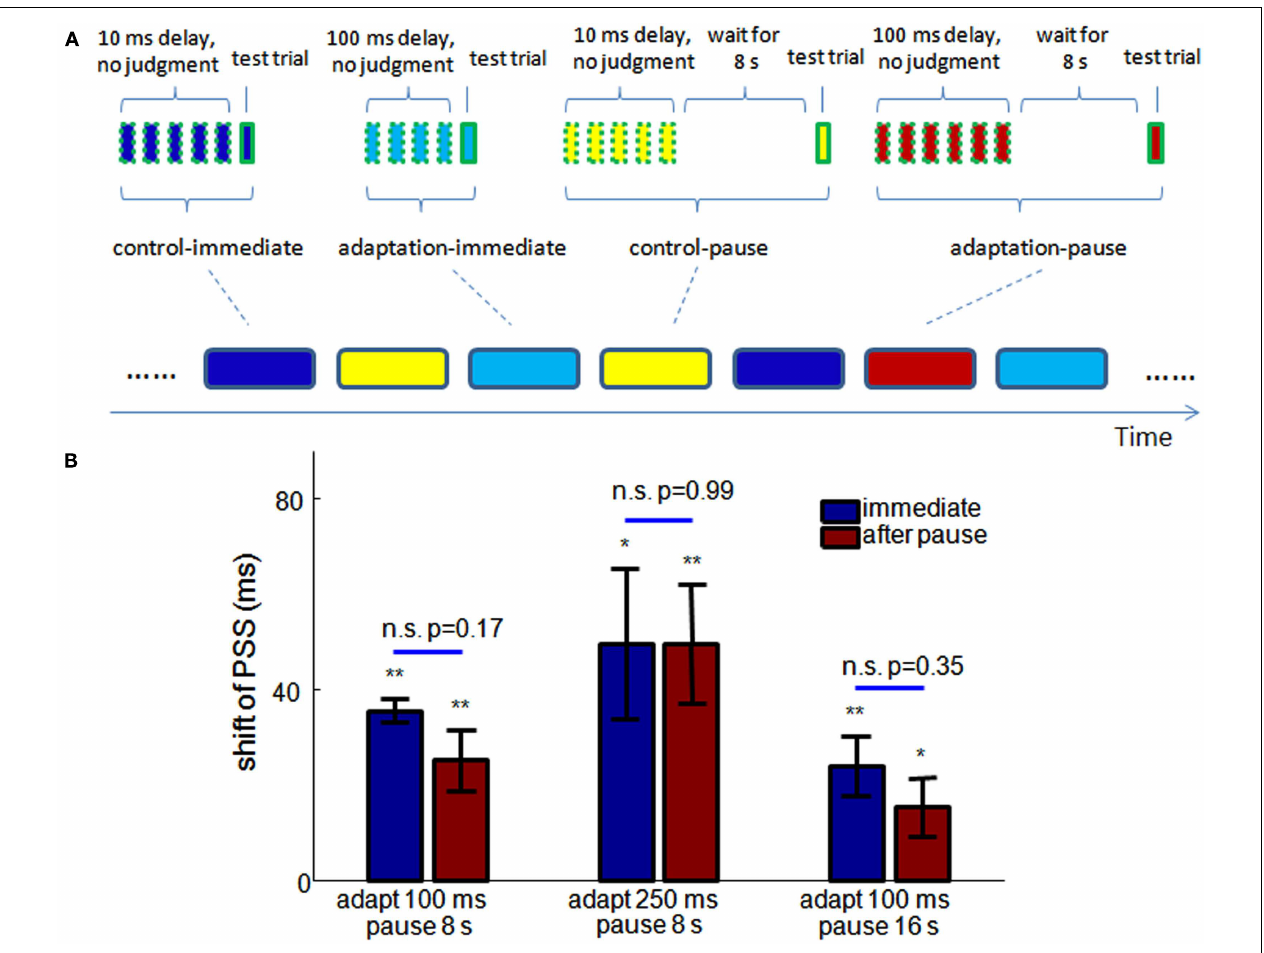
(B) The shifts of PSS from control to adaptation conditions in the three experiments ( n =10, 10, 9). No significant difference of the shifts of PSS is observed with and without a pause before a test trial, in any of the experiments. Blue: test trial immediately follows adapting trials. Red: a pause is inserted between adapting trials and the test trials. *significantly different from 0, p <0.05, ** p <0.01. Errorbar: